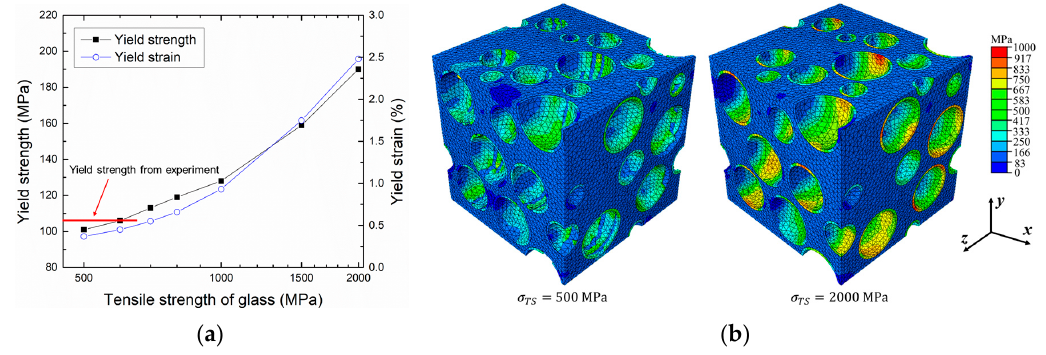
Figure 6. ( a ) Effect of tensile strength of the glass on the yield strength and strain of the iron syntactic foam; ( b ) Equivalent stress fields of model at 0.7% x -axial strain using 500 and 2000 MPa for the tensile strength of the glass. σ TS denotes the tensile strength of the glass.